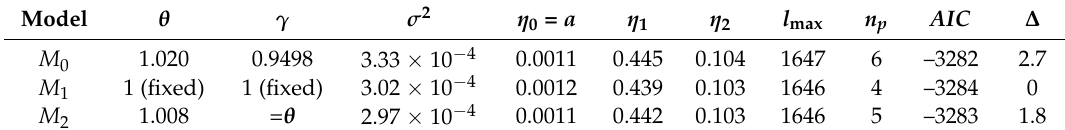
Table 6. Resistor application: parameter estimates for three candidate models with deterministic drift coefficients ( b = 0).